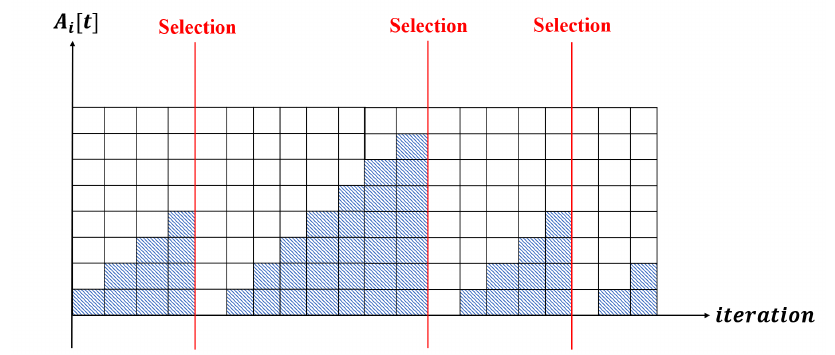
Figure 6. Example of A i [ t ] of client c i .